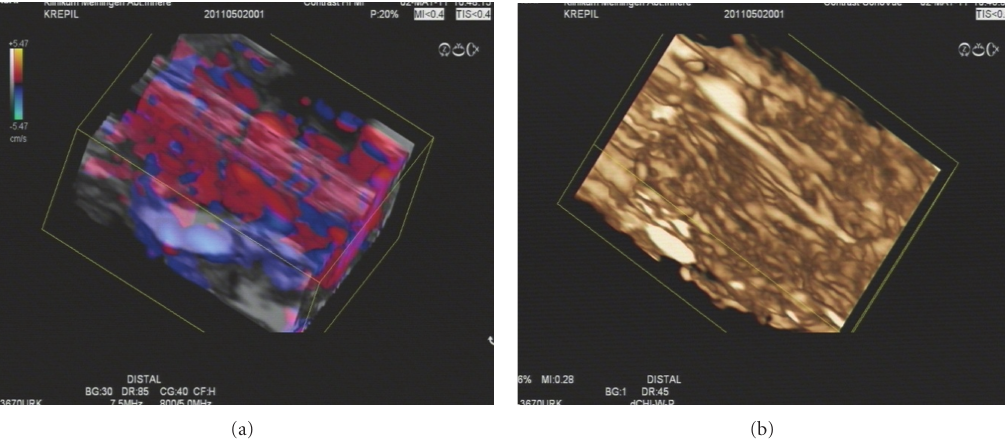
Figure 4: Contrast-enhanced high and low mechanical index endoscopic ultrasound with 3D reconstruction: (a) dense vessel involvement of the pancreas is impressively visible; all the red and blue spots are the Doppler colour signals from a section of the pancreas; (b) the influx of contrast enhancer is shown clearly in the low MI reconstruction to have spread homogenously through the